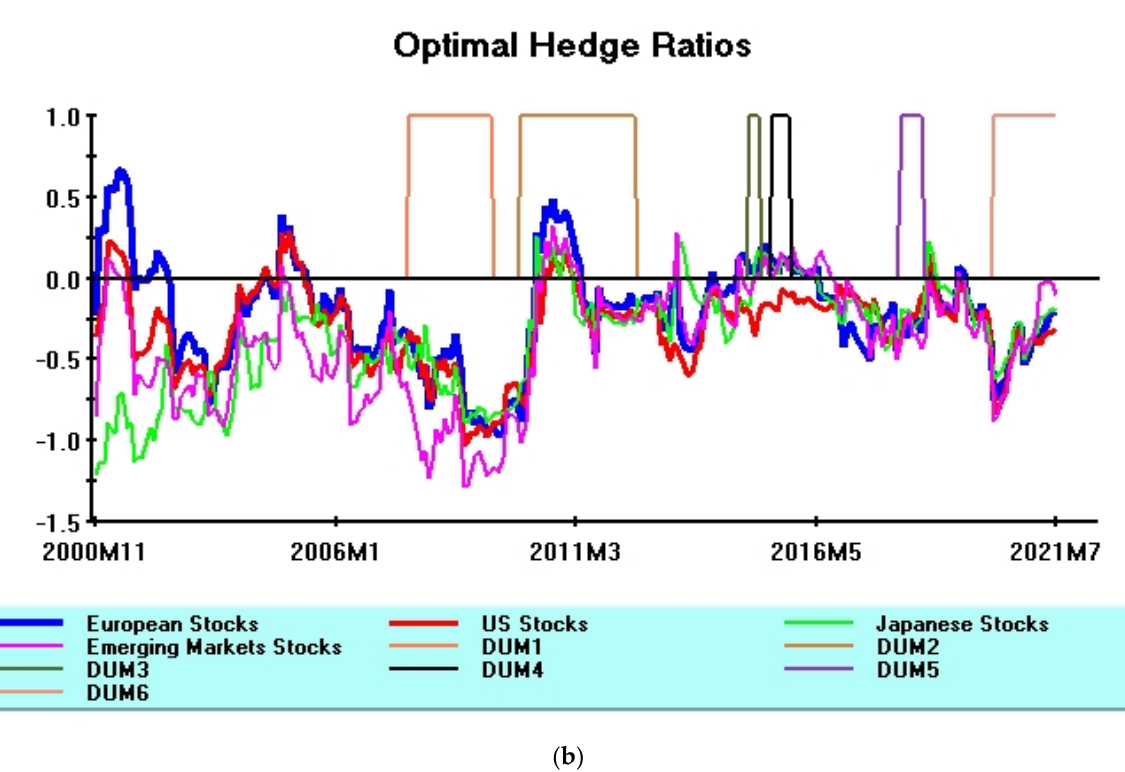
Figure 2. ( a ) Gold as a safe haven asset; ( b ) Swiss Franc as safe haven asset.